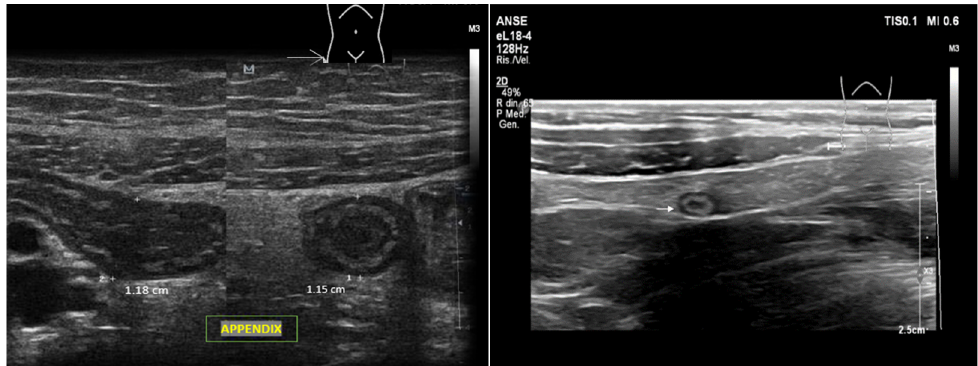
Figure 9. Ultrasonography of the right upper quadrant. A distended gallbladder with microlithiasis and large biliary sludge ( left ); multiple stones with posterior shadowing in the infundibulum ( right ).